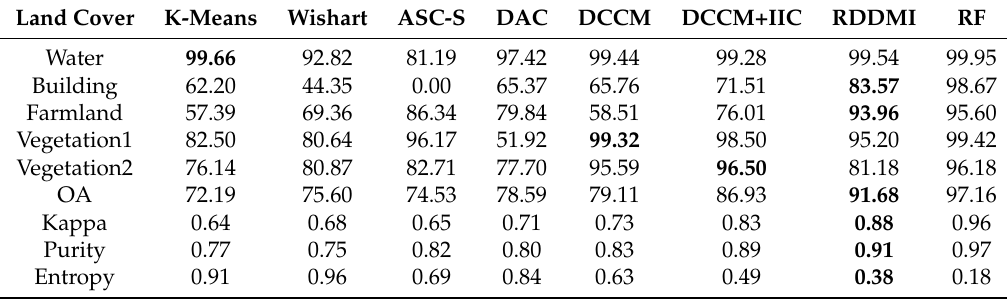
Figure 9. Classification results of GF-3 Wuhan dataset. ( a ) Ground truth map; ( b ) K-means; ( c ) Wishart; ( d ) ASC-S; ( e ) DAC; ( f ) DCCM; ( g ) DCCM+IIC; ( h ) RDDMI. Table 2. Performance evaluation of GF-3 Wuhan classification results. The numbers in bold denote the best unsupervised classification performance.